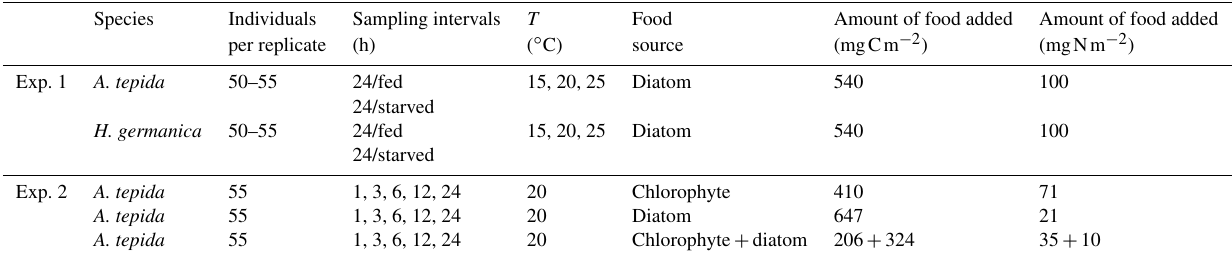
Table 1. Experimental setup and